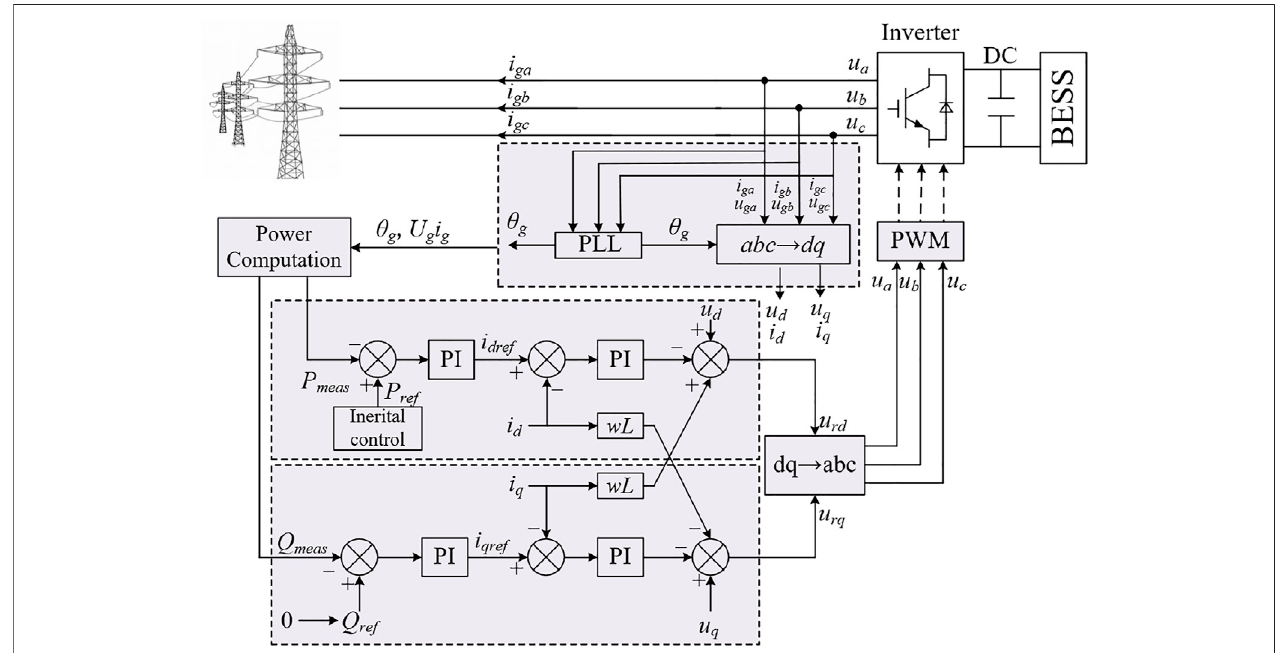
FIGURE 2 | Control system of the